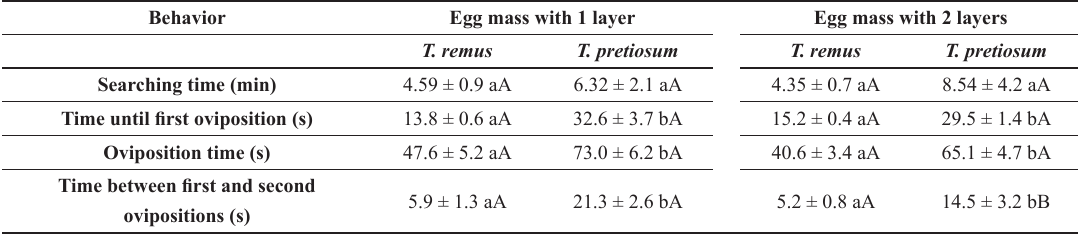
Mean time (± SE) spent performing different oviposition behaviors on Spodoptera frugiperda egg masses with one or two egg layers by Telenomus remus and Trichogramma pretiosum